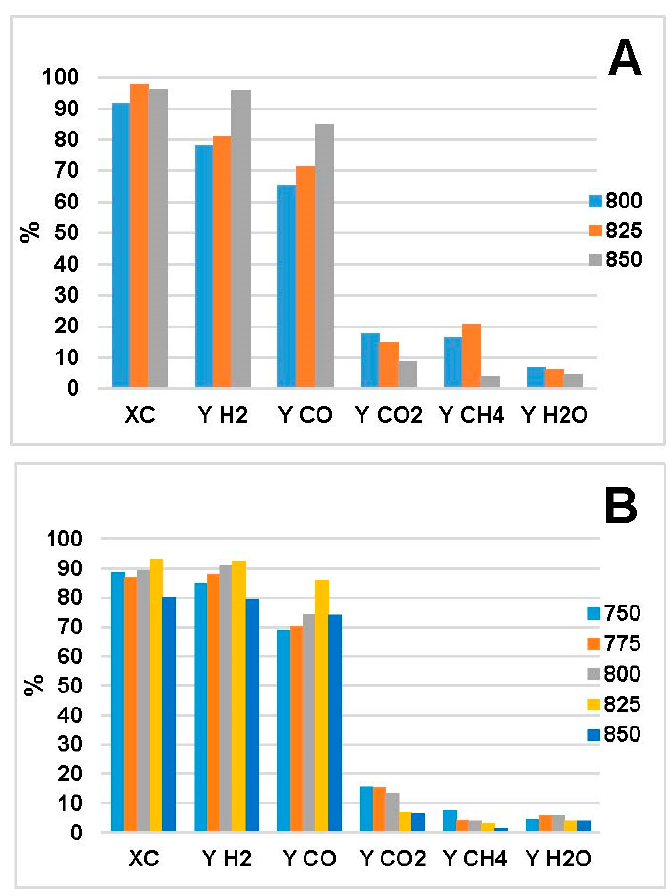
Figure 1. Results of bio-oil MemU SR: ( A ) WHSV = 6.6 g/g cat /h; and ( B ) WHSV = 1.7 g/g cat /h.